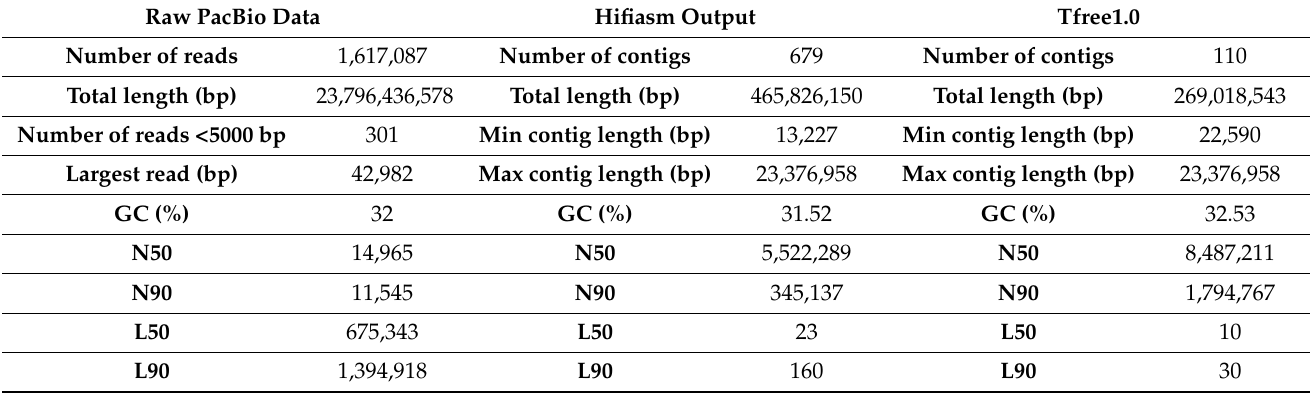
Table 2. Statistics of raw PacBio HiFi data, contigs obtained using hifiasm assembler, and contigs used for assembly with RagTag algorithm producing the assembly